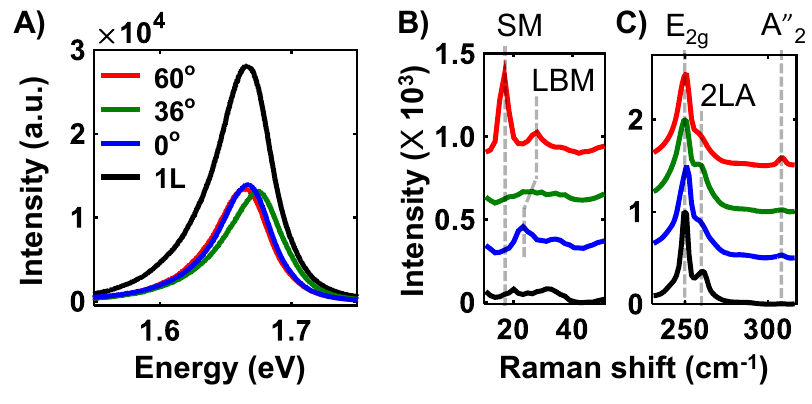
Figure 2: (A) Room temperature PL spectra; (B) Low frequency Raman spectra and (C) High frequency Raman spectra of 1L and BL-WSe 2 for different stacking angles. The characteristic low frequency shear mode (SM) and layer breathing mode (LBM) and higher frequency E 2 g , 2LA, and A ″ 2 modes are marked with vertical dashed